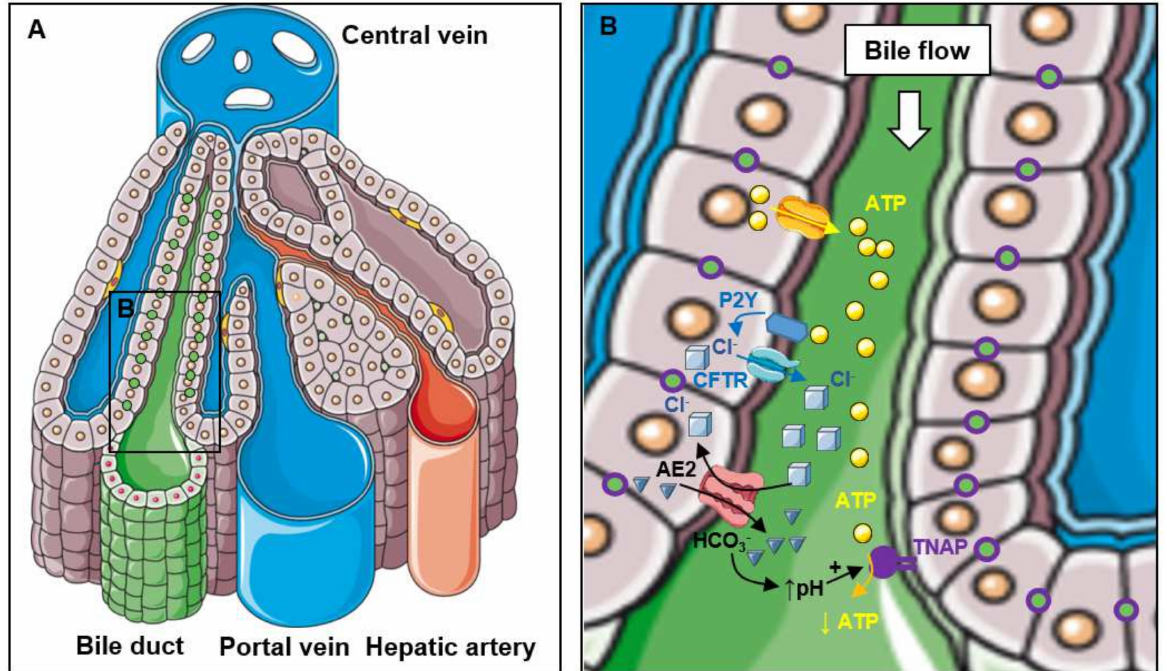
Figure 2. Function of TNAP in bile excretion ( A ) Rough presentation of liver structures indicating the region presented in ( B ). ( B ) Typical organization of hepatocytes delimitating bile canaliculi, showing from the top to the bottom the sequence of molecular events involved in pH regulation during bile